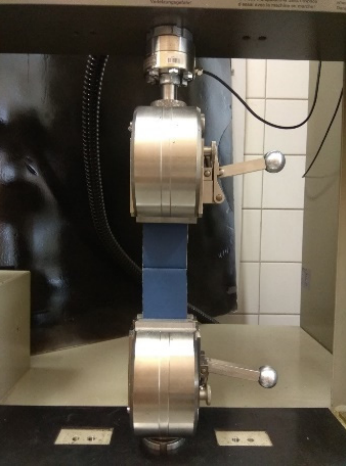
Figure 2. Sample testing station. Table 2. Zwick 1445 testing parameters.